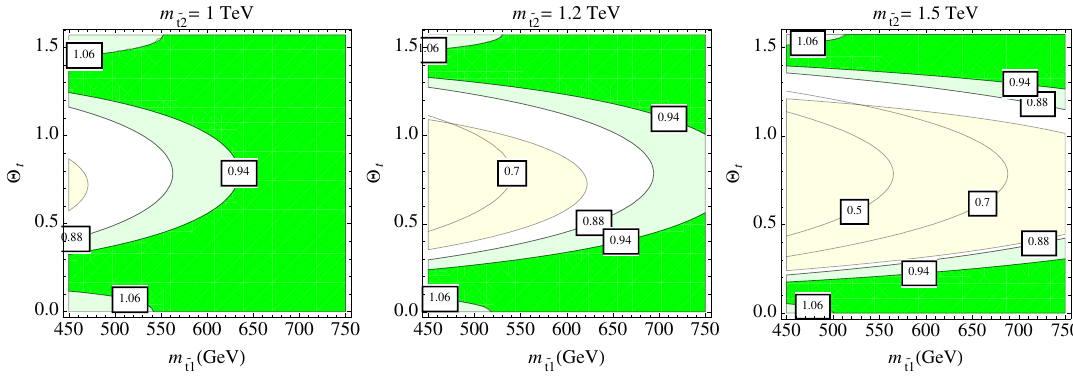
Figure 3 . Contours of r gg as a function of m ~ m ~ : 1 : 0 ; 1 : 2 ; and 1 : 5 TeV in the left, center, and right panels. Light (dark) green regions t 2